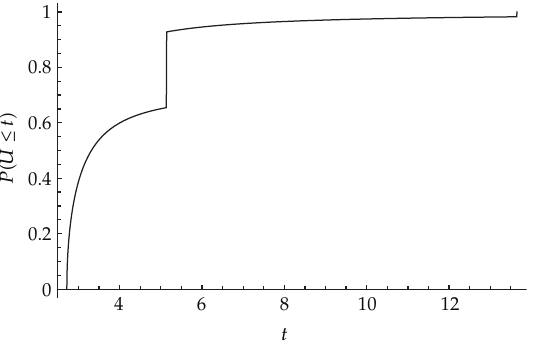
Figure 2: CDF of U for θ (cid:6) 1, x 1 (cid:6) 2, n 1 (cid:6) 5, σ (cid:6) . 5, a (cid:6) . 25, and b (cid:6)